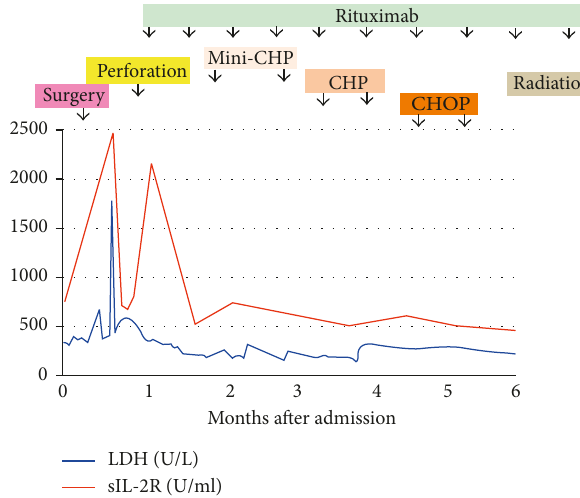
Figure 4: Time course of changes in laboratory data in response to treatment. Serum levels of lactate dehydrogenase (LDH) and sIL- 2R in response to duodenal perforation and various therapeutic regimens. Details of treatment regimens are in the